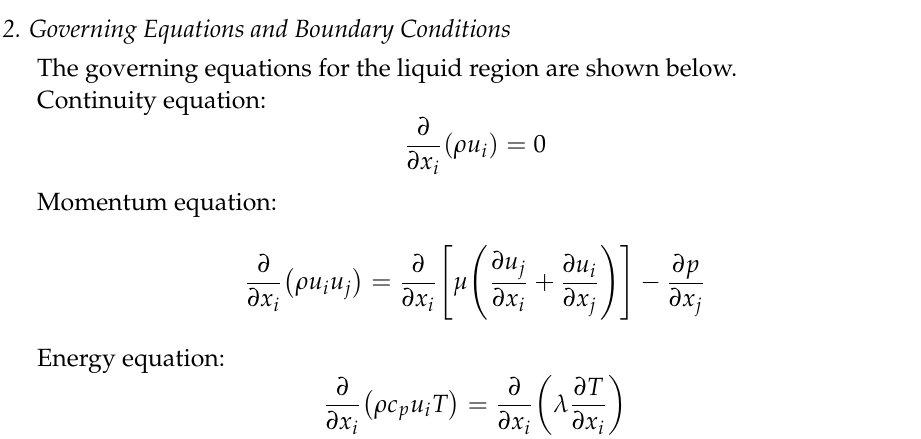
Figure 3. A schematic diagram of the liquid flow direction in the lower microchannel layer.